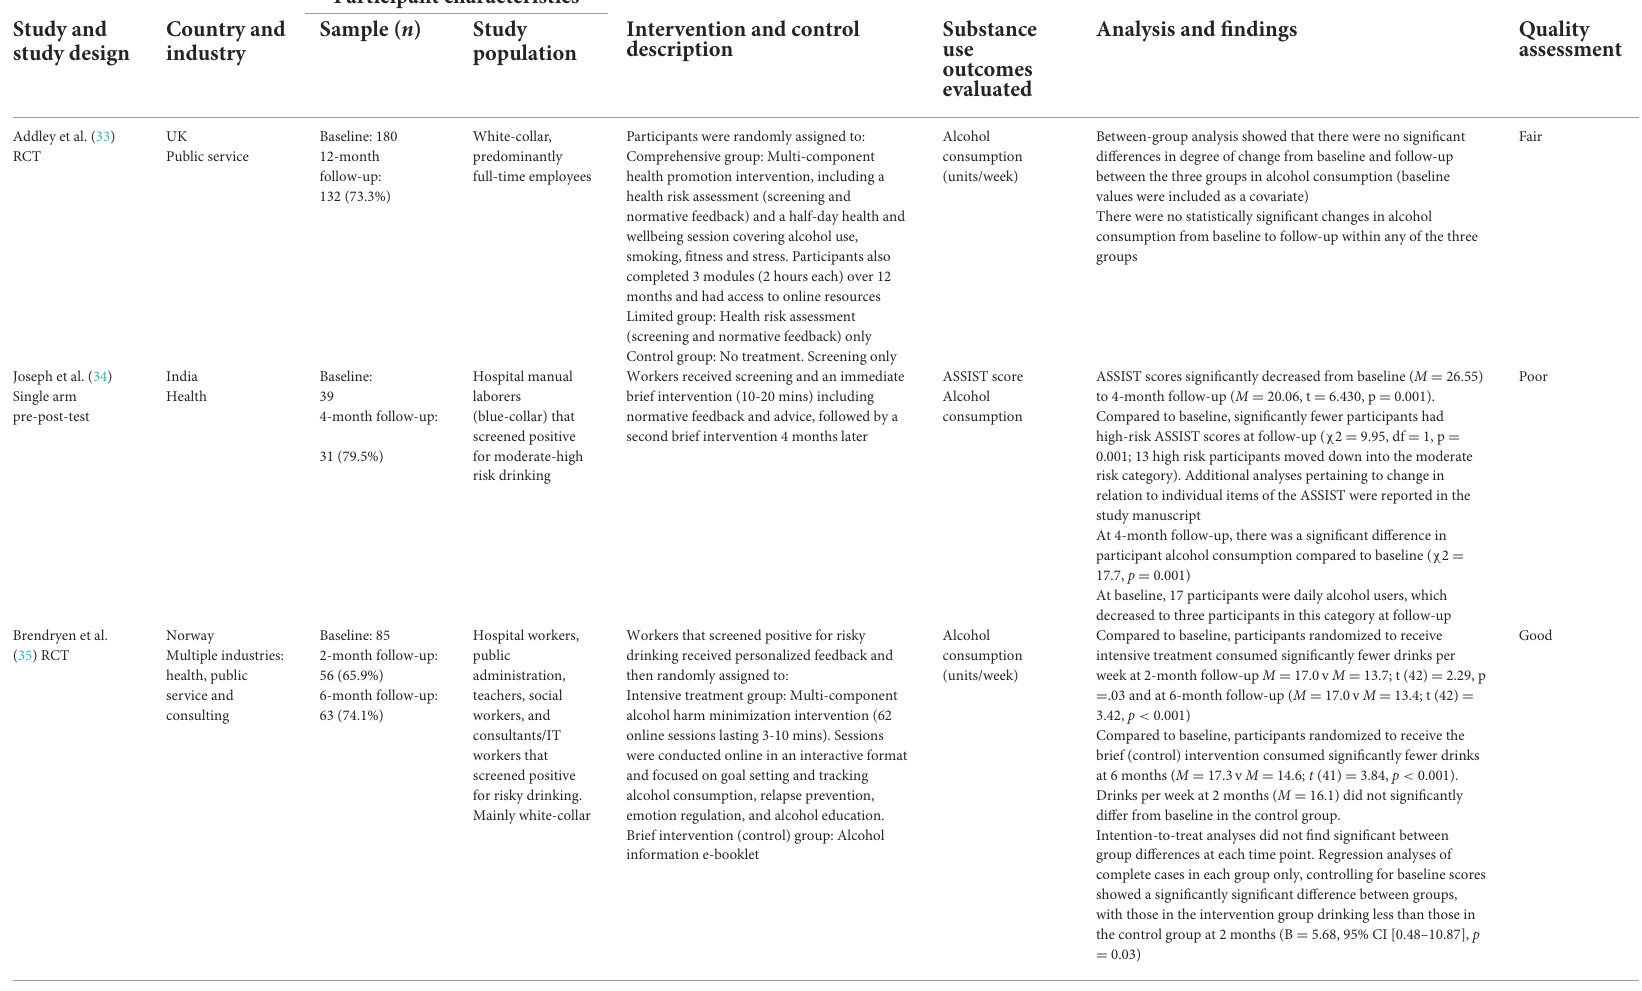
TABLE 1 Characteristics of primary studies evaluating the effectiveness workplace-based interventions for the prevention and treatment of problematic substance